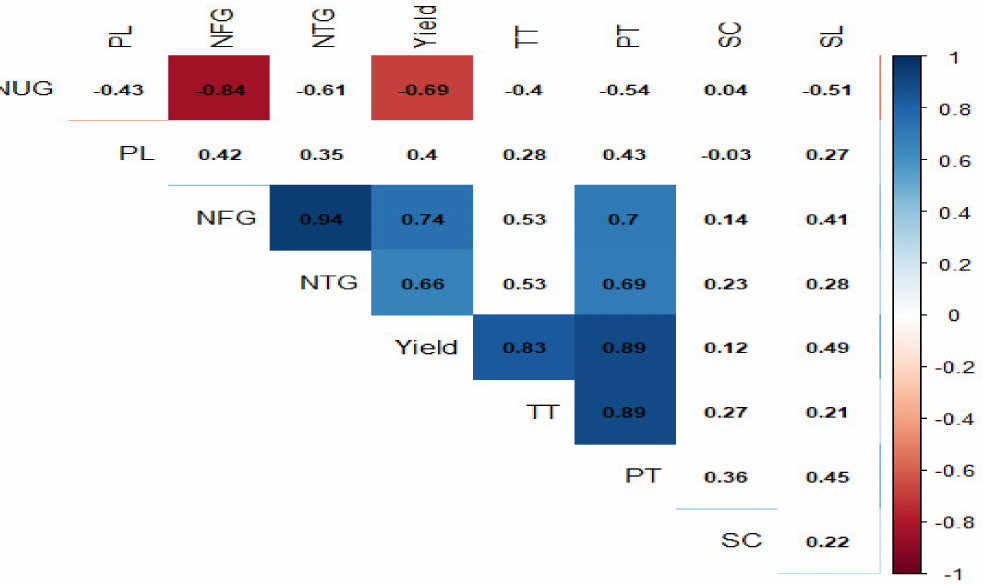
Figure 2. Correlation analysis of rice growth characters (notes: PH = plant height, TT = total tiller, PT = productive tiller, SC = stomata count, SL = stomata length, NFG = number of filled grains, NUG = number of unfilled grains, NTG = number of total grains, and yield = rice yield).